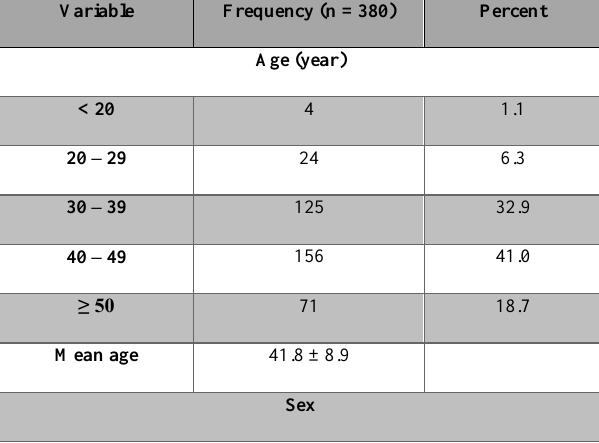
Table 1. Socio-Demographic Characteristics of The